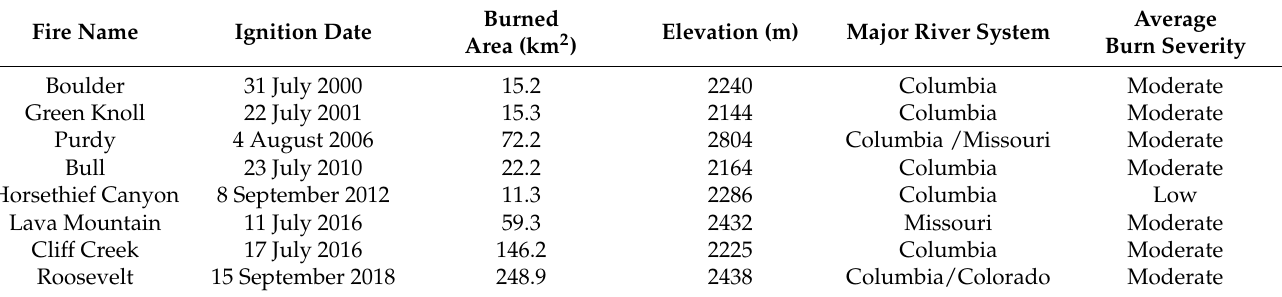
Table 1. Characteristics of eight forest fire sites used in this study.